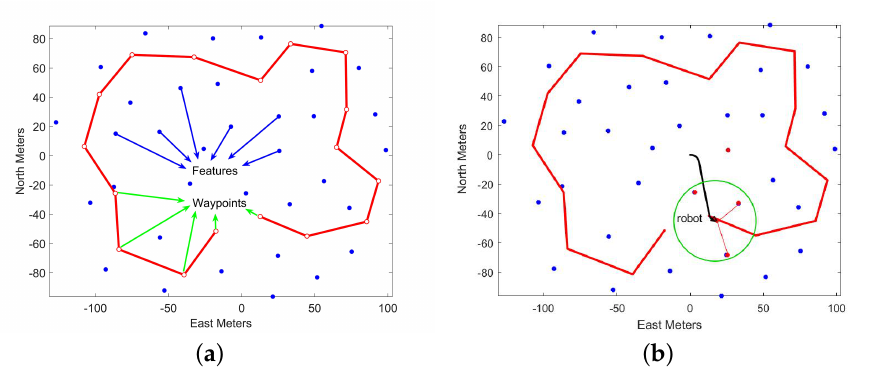
Figure 5. Simulation interface. ( a ) Simulation environment. ( b ) A screenshot of the process of